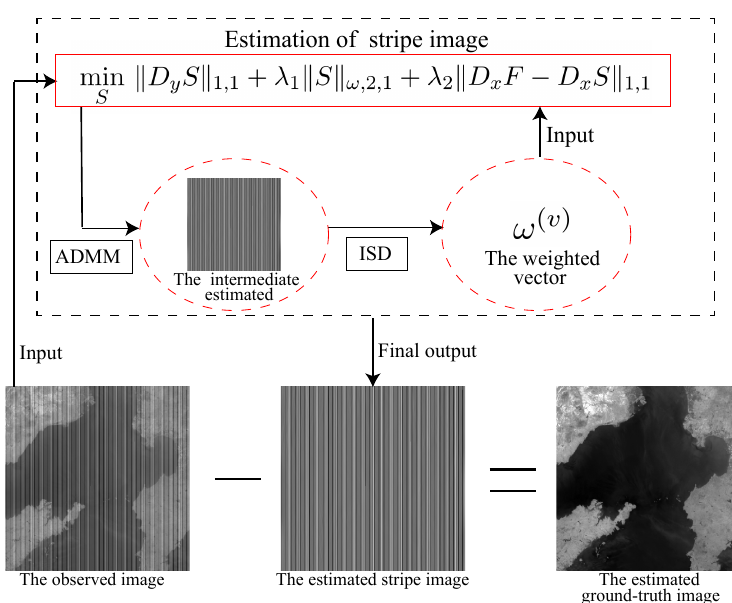
Figure 2. The framework of the proposed model. ADMM, alternating direction method of multipliers; ISD, iterative support